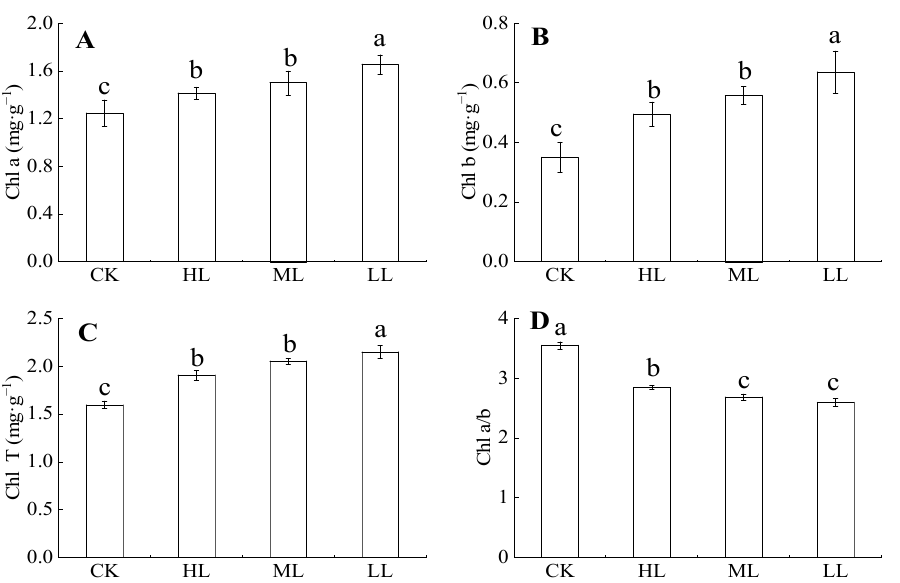
Figure 4. The content of chlorophyll in C. oleifera under different light intensity treatments. Note: Parameters include Chl a (Chlorophyll a content; A ), Chl b (Chlorophyll b content; B ), Chl T (total chlorophyll content; C ), and Chl a/b (Chlorophyll a/b content; D ) of C. oleifera under different light regimes. Different lowercase letters (a, b, c) indicate significant differences between light regimes (p < 0.05). Regime acronyms are defined as CK: 100% light regime; HL: 75% light regime; ML: 50% light regime; LL: 30% light regime.